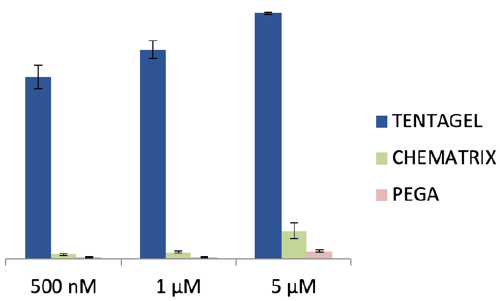
Figure 3. MRD concentrations: 500 nM, 1 μM, and 5 μM. Data collected for six random beads per resin.